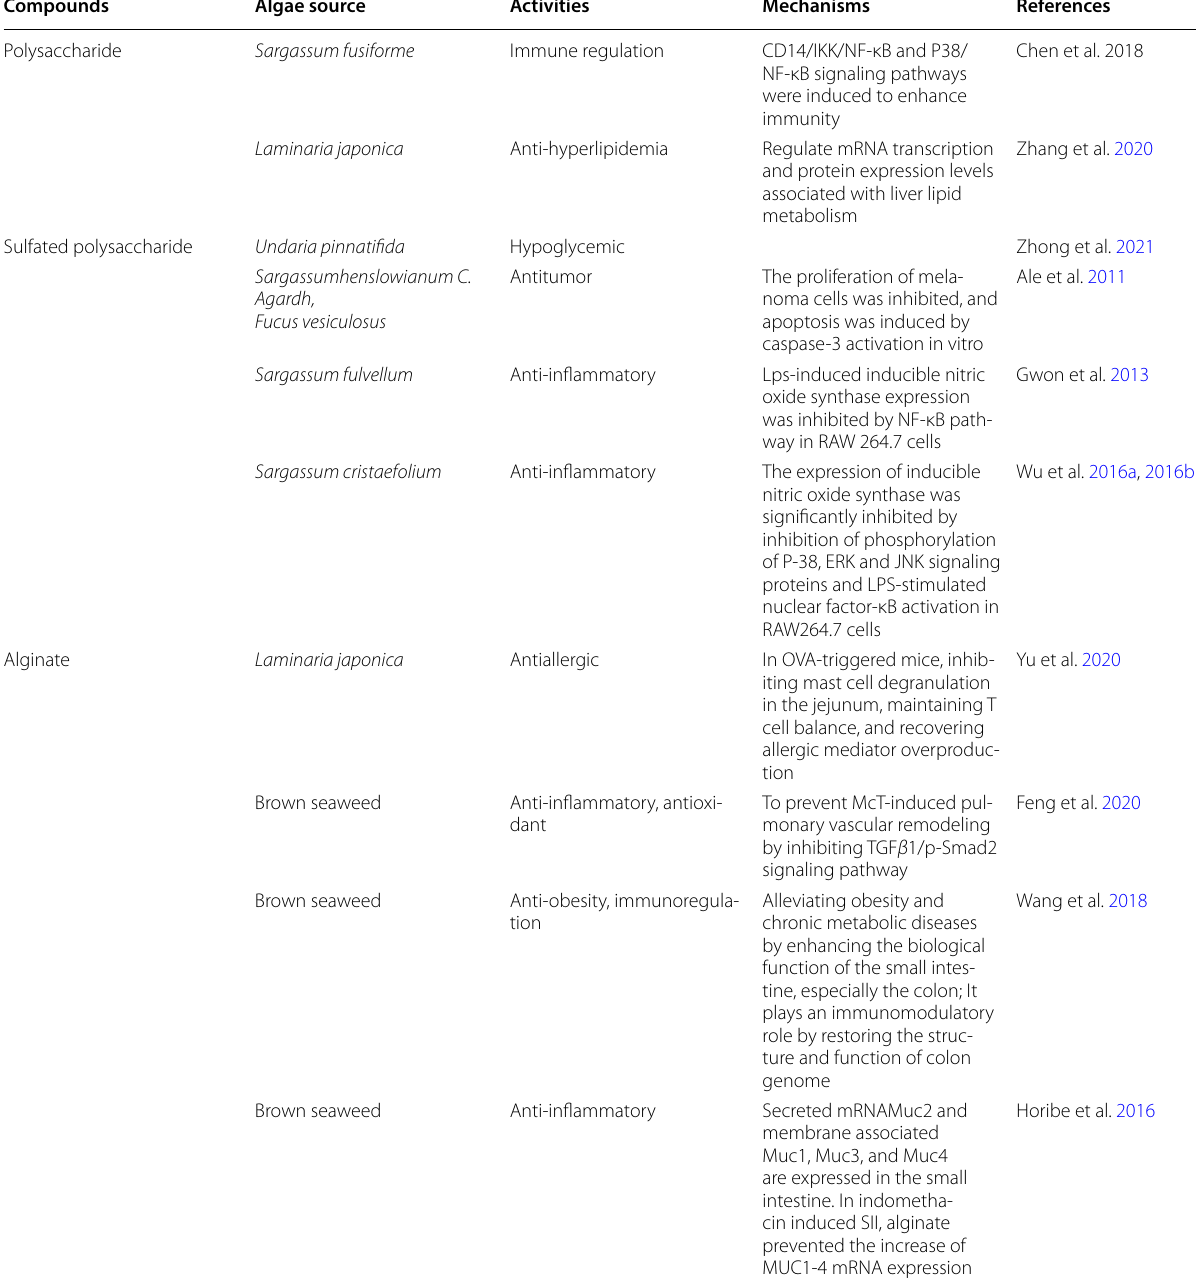
Table 1 The bioactivity and characteristics of brown seaweeds